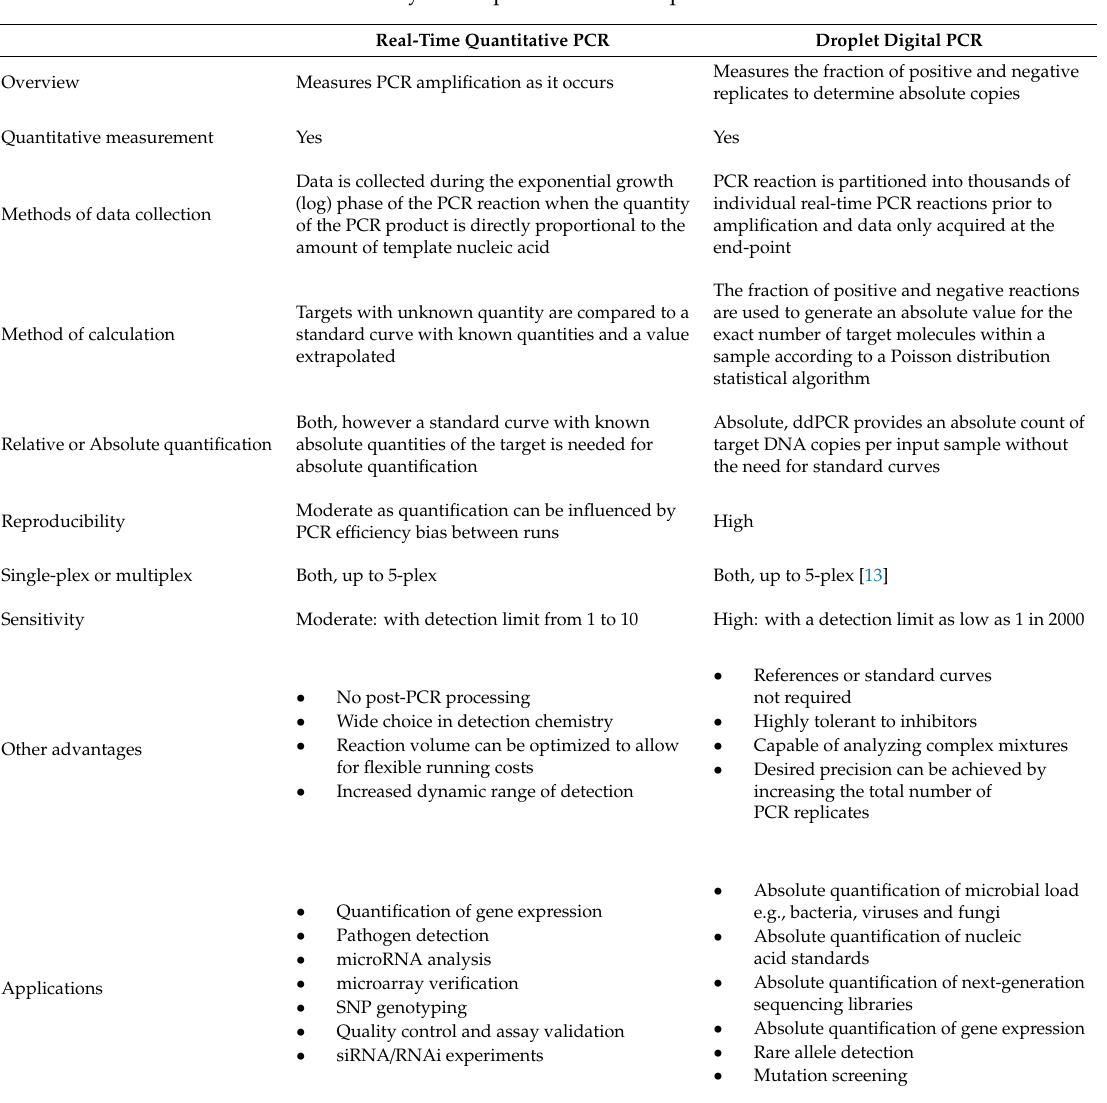
Table 1. Summary of comparison between qPCR and